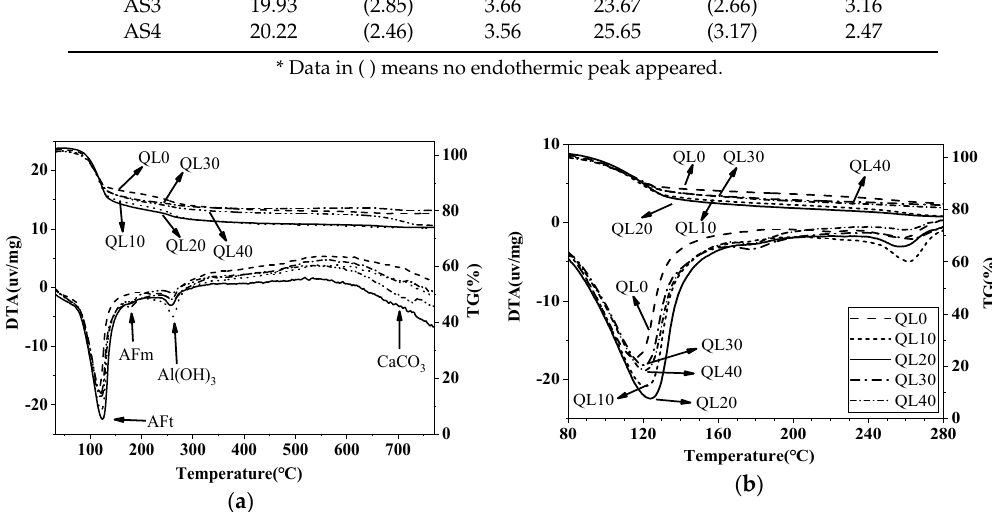
Figure 15. TG-DTA curves of the double liquid grouting materials with different quicklime content at 1 day: (a ) Temperature ranges from 40–750 °C; ( b ) Temperature ranges from 80–280 °C.